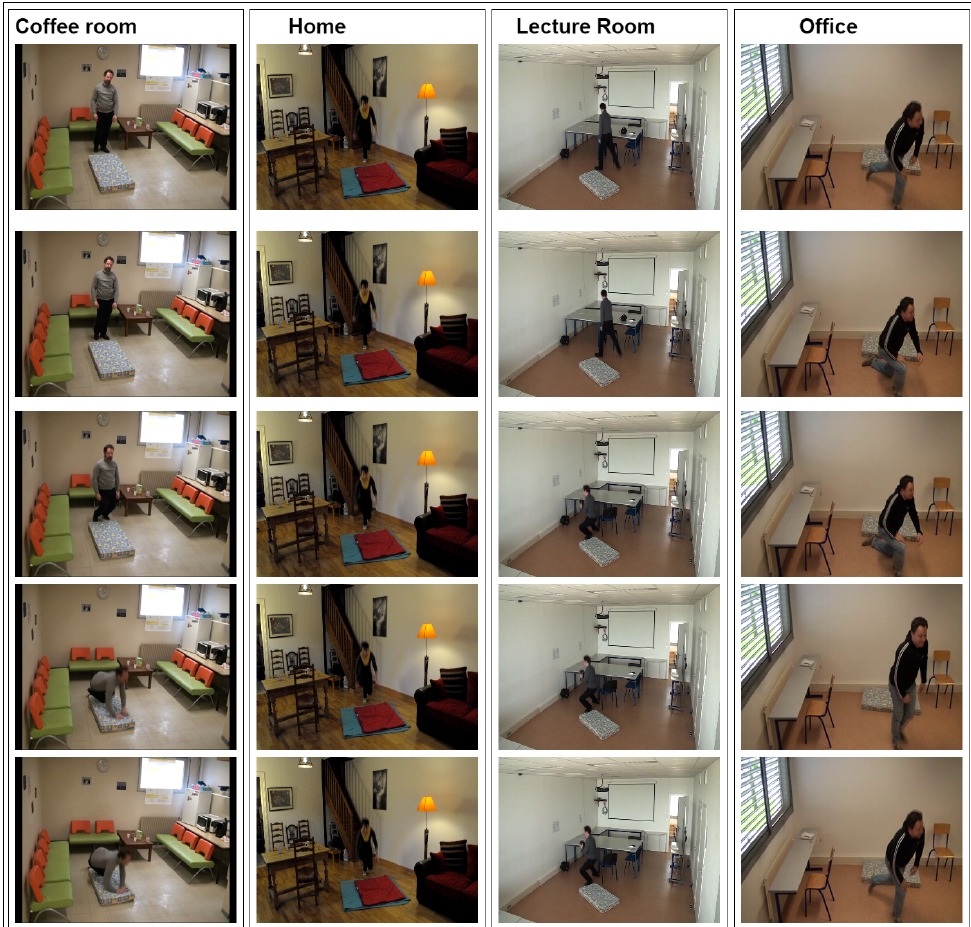
Figure 3. Charfi dataset: Examples frames taken from lecture room, home, coffee room and office